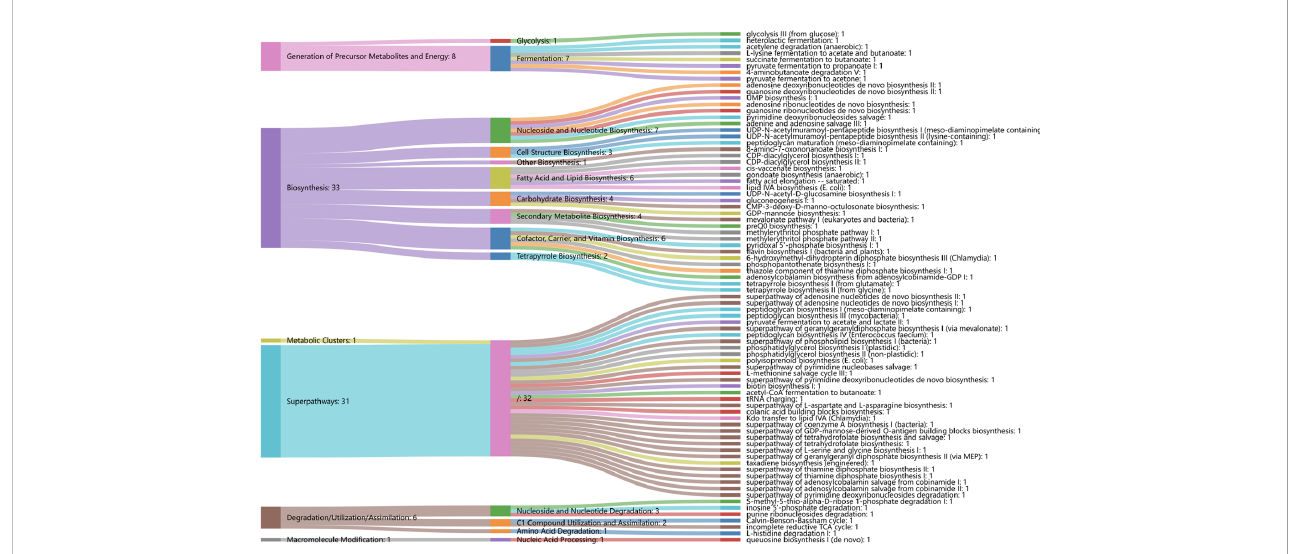
FIGURE 6 Differentially functional alternations in cervical cancer and controls. Sankey diagram displayed the associations between the differential functional pathways and metabolic reactions. Metabolic reactions were grouped by the MetaCyc pathway categories.